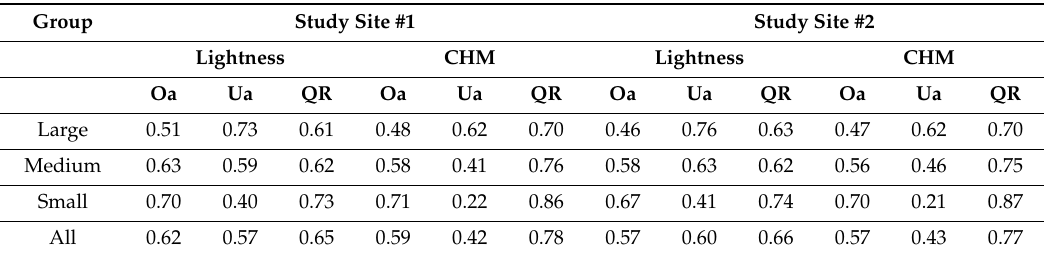
Figure 5. Impact of spatial resolution and crown size on Oa, Ua, and QR using the CHM in study site #2. Table 1. Average accuracy measures of all spatial resolutions using lightness or CHM from each study site.